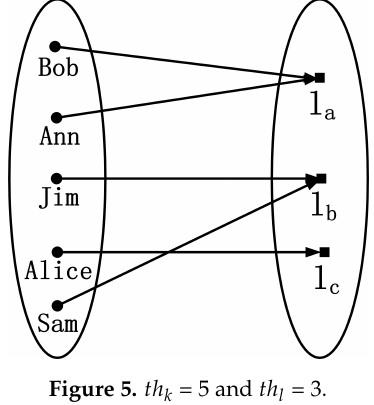
Figure 5. th k = 5 and th l = 3.